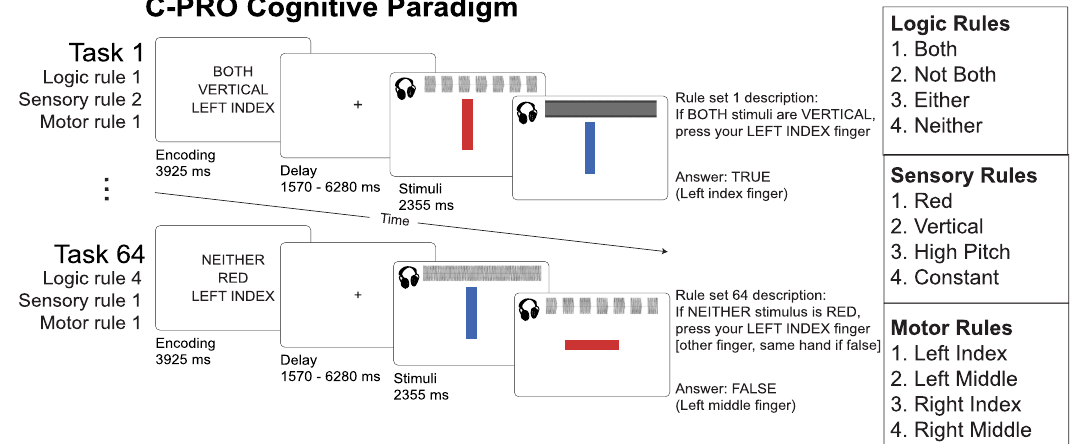
Fig. 2 The Concrete Permuted Rule Operations (C-PRO) task paradigm. Adapted with permission 8 . For a given trial, subjects were presented with a task rule set (context), in which they were presented with three rules sampled from three different rule domains (i.e., logical gating, sensory gating, and motor selection domains). After a delay period, subjects applied the task rule set to two consecutively presented sensory stimuli (simultaneous audiovisual stimuli) and responded accordingly with button presses (index and middle fi ngers on either hand). We employed a miniblock design, in which for a given task rule set, three stimulus periods were presented separated by an inter-trial interval (1570 ms). See Methods for additional details.